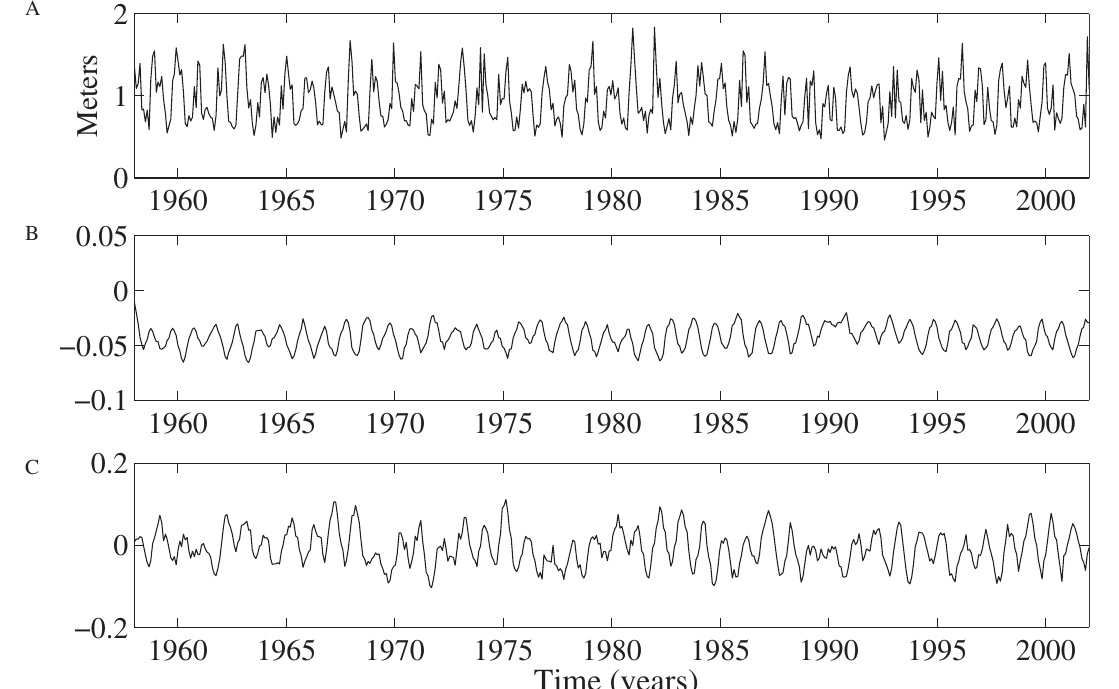
Fig . 4. – (a-top) time evolution of the spatial mean computed from 528 months for sWH, (b, c) time amplitudes for the first two eofs.